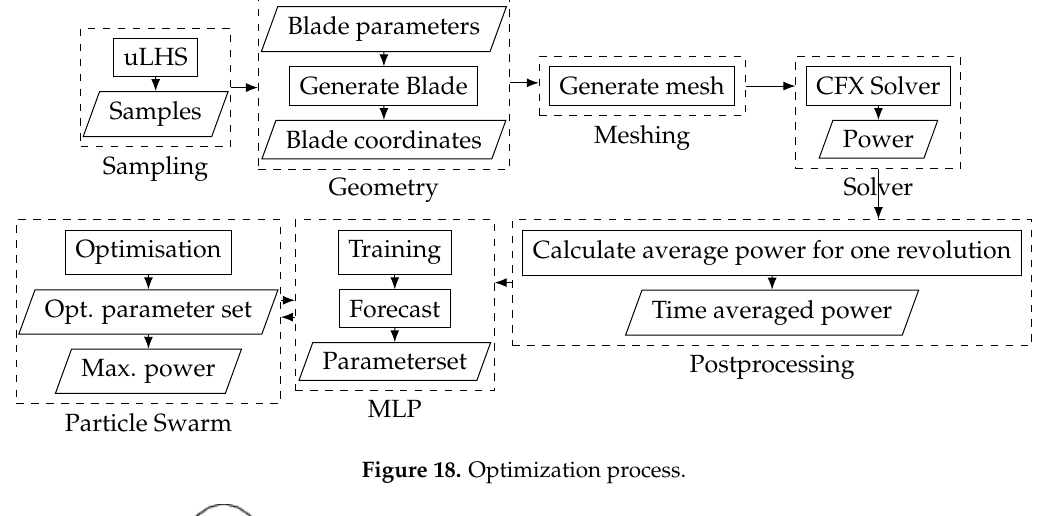
Figure 18. Optimization process.